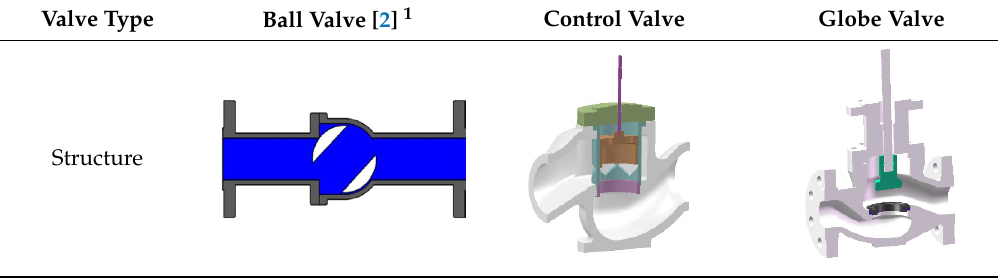
Table 1. Common valves applied in different industries.